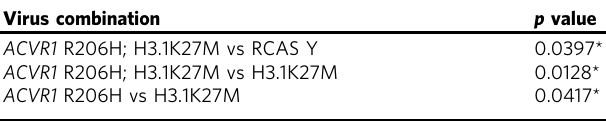
Table 3 ACVR1 R206H and H3.1K27M signi fi cantly decrease survival in tumors Virus combination